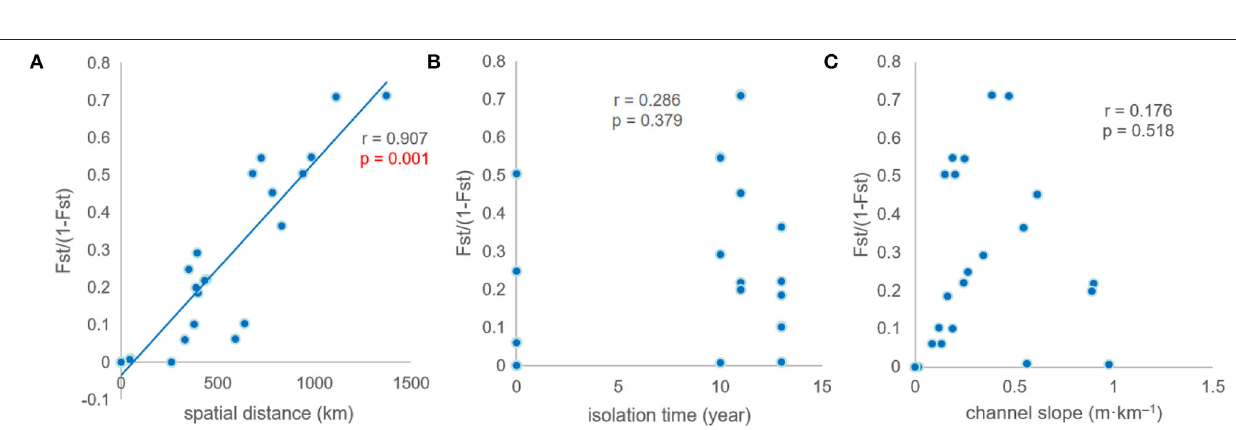
Frontiers in Ecology and Evolution |